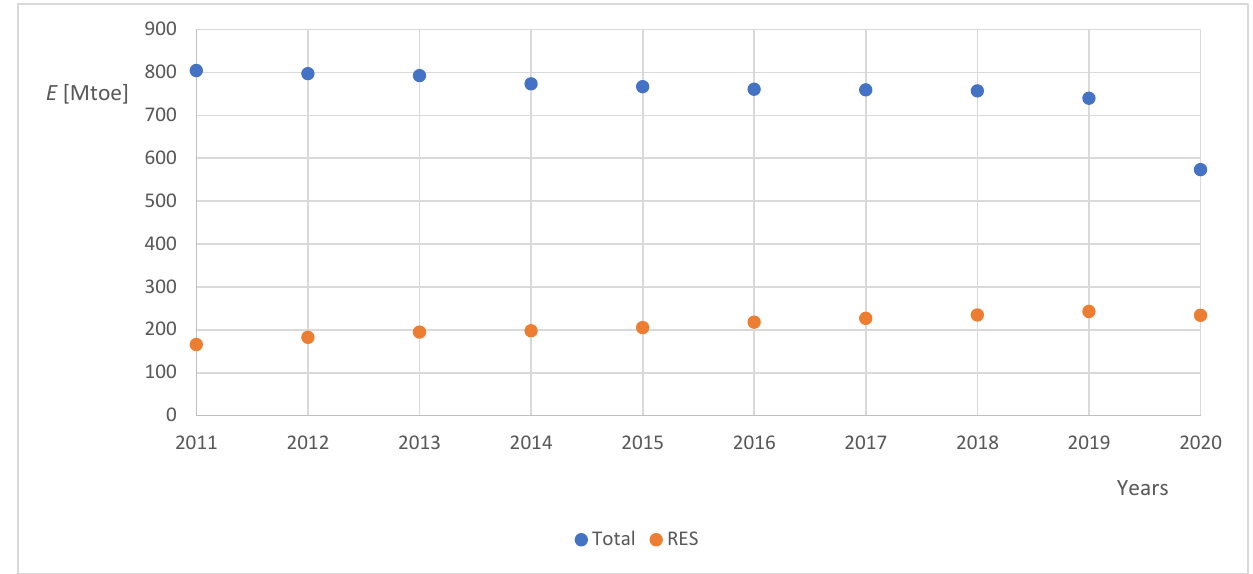
Figure 1. Obtaining primary energy, including energy from renewable sources (RES), in the European Union, according to Table 18 (own elaboration).